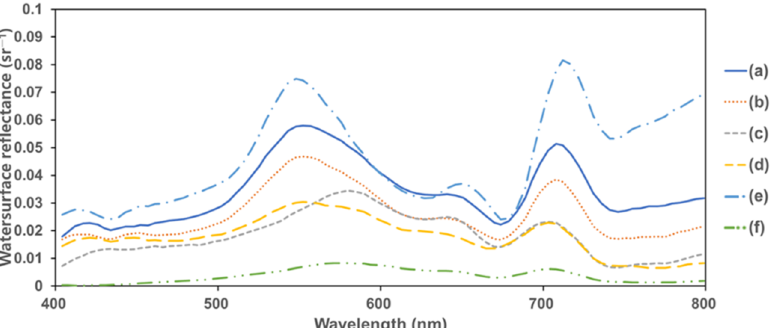
Figure 2. A hyperspectral reflectance curve extracted from a sampling point. The positions of peak and absorption were shifted according to the concentration of the water quality factors. (a) PC, 146.99; Chl-a, 111.4; and SS, 40.14. (b) PC, 54.81; Chl-a, 66.18; and SS, 16.93. (c) PC, 1.54; Chl-a, 60.88; and SS, 16.67. (d) PC, 15.89; Chl-a, 51.54; and SS, 9.47. (e) PC, 100; Chl-a, 36.78; and SS, 13.2. (f) PC, 8.93; Chl-a, 17.52; and SS, 7.33.